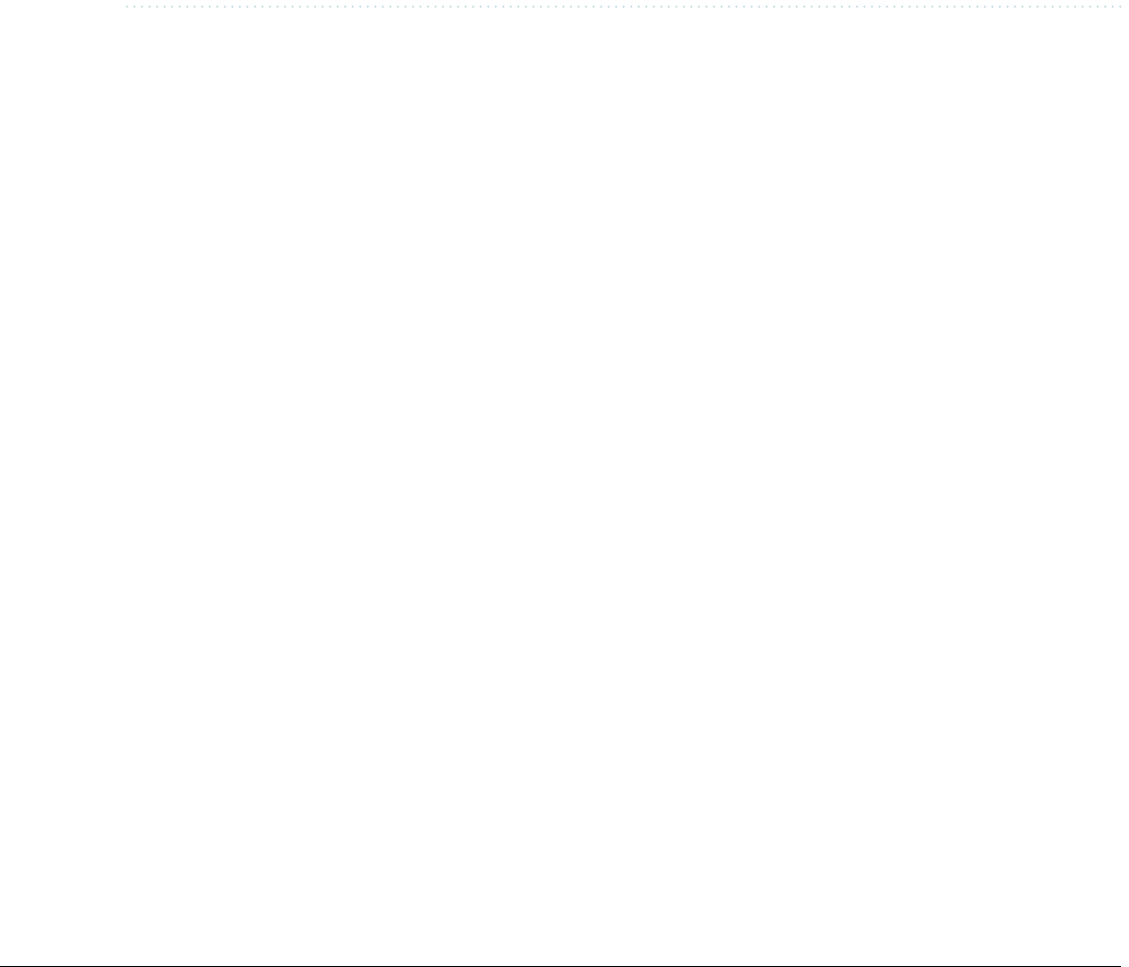
Figure 3. Crude and adjusted serum BDNF values (mean ± SE) across quartiles of fat (as percentage of energy intake) and energy-adjusted omega-3